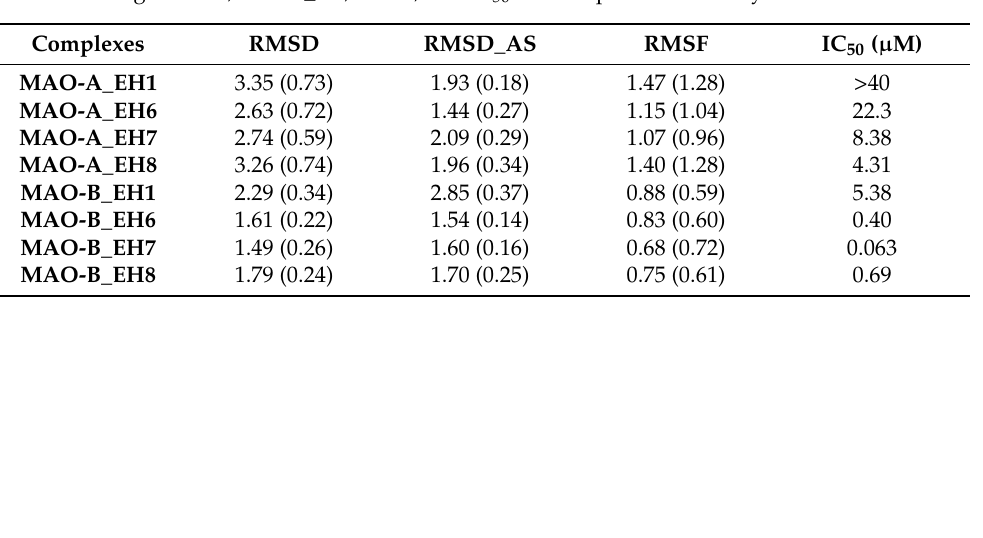
Table 3. Average RMSD, RMSD_AS, RMSF, and IC 50 of the Apo and bound